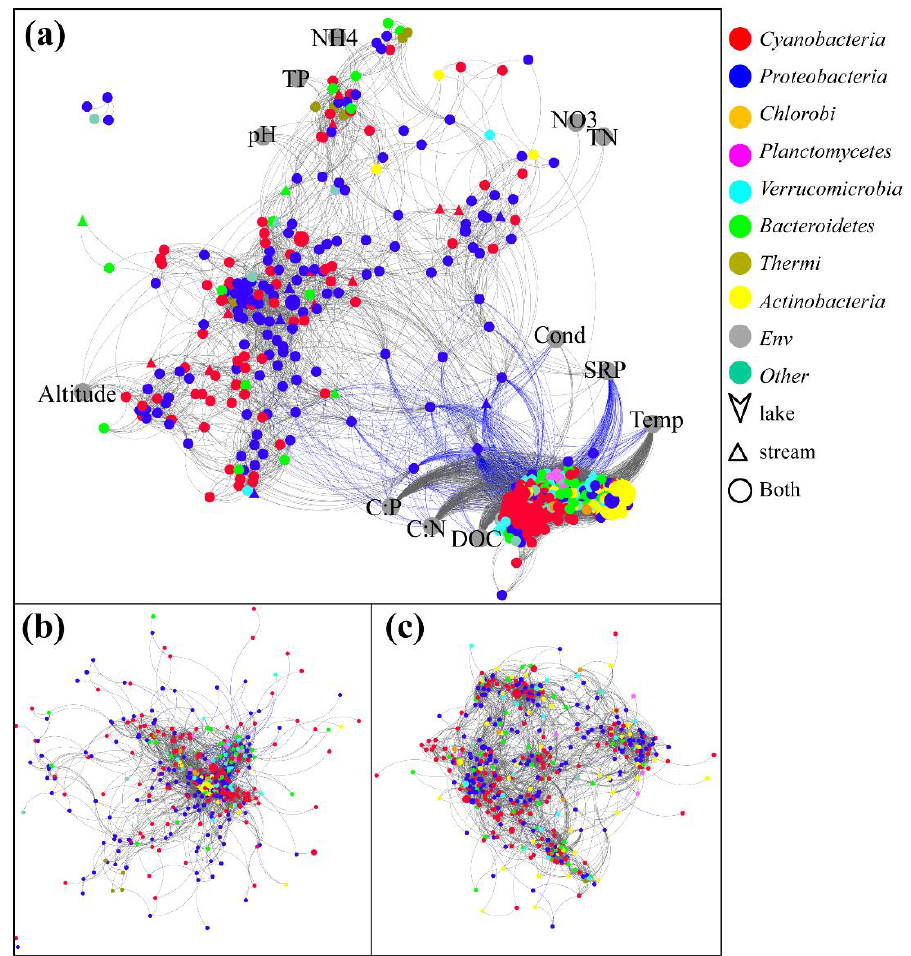
Figure 5. Co-occurrence networks of bacterial communities in integrated lake / stream ( a ), Erhai Lake ( b ), and streams ( c ). Nodes represent the OTUs. Edges represent Spearman’s correlation relationships, and only strong and significant correlations (Spearman’s r > 0.6 or r < − 0.6, p < 0.01) are shown. The grey and the blue lines indicate positive and negative correlations, respectively. Table 2. Topological parameters of real co-occurrence networks and corresponding random networks (some parameters of the random network are shown in mean ± SD. SD represent standard deviation).